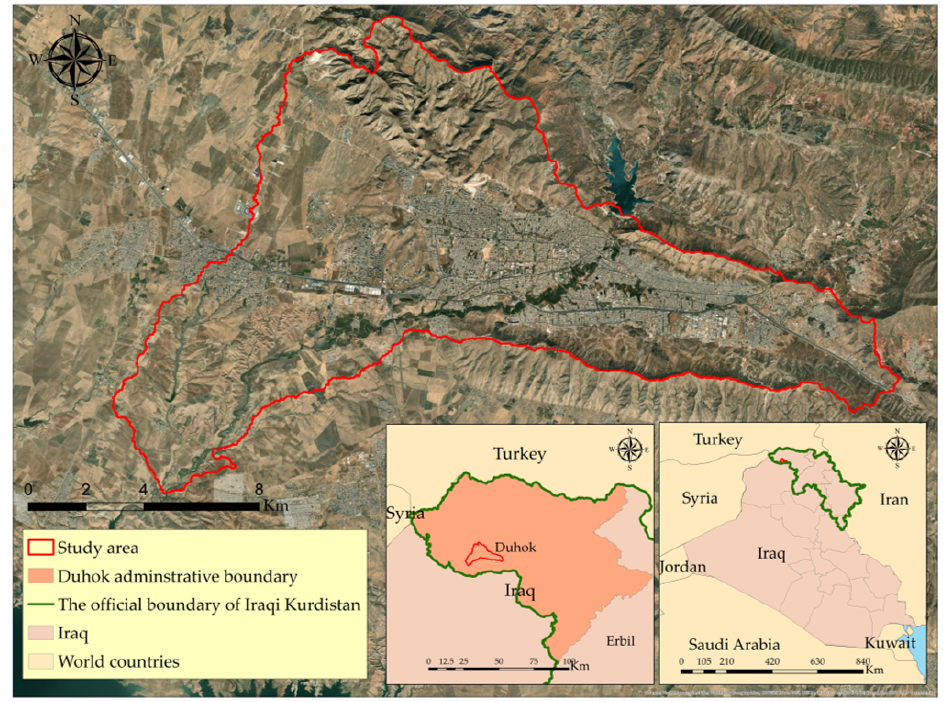
Figure 1. Study area. (Base imagery sources: Esri, DigitalGlobe, GeoEye, i-cubed, USDA FSA, USGS, AEX, Getmapping, Aerogrid, IGN, IGP, swisstopo, and the GIS User Community).